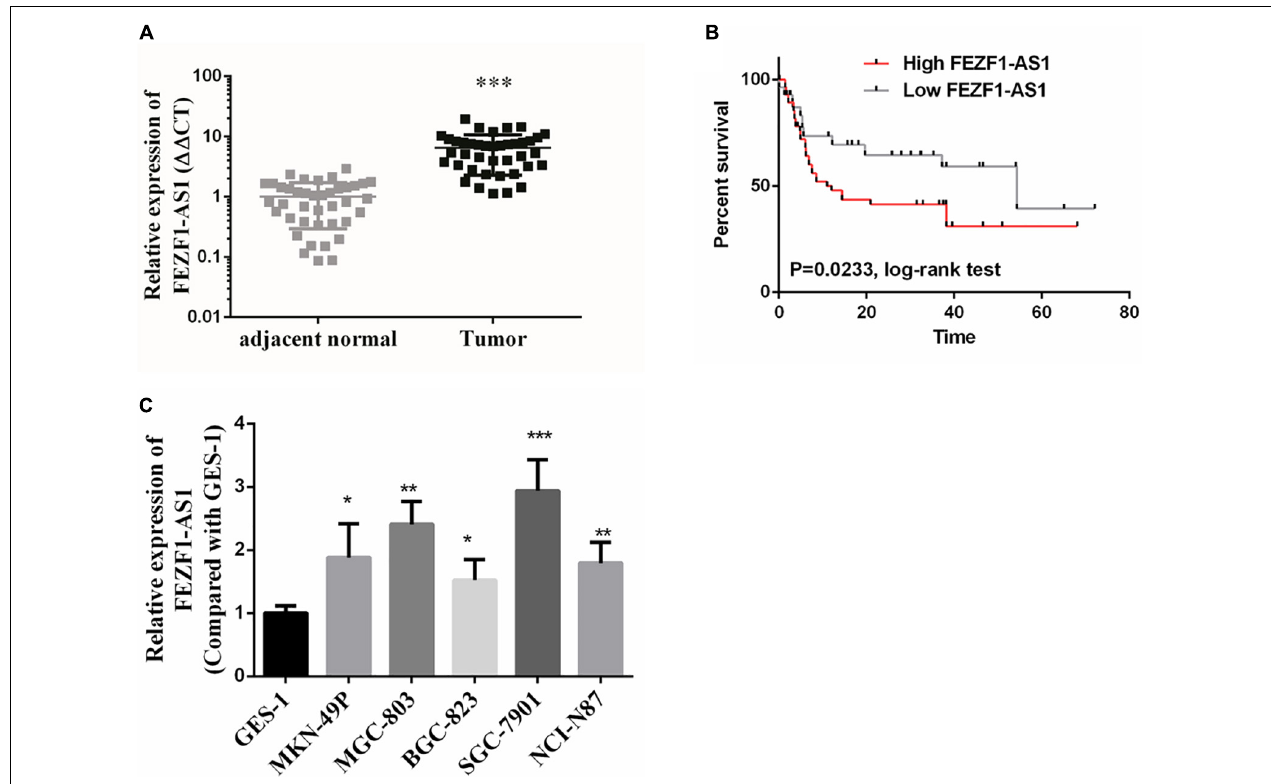
FIGURE 1 | FEZF1-AS1 was upregulated in gastric cancer (GC) tissues and cell lines. (A) Relative expression of FEZF1-AS1 in 40 paired GC tissues and pair-matched adjacent normal tissues quantified by qRT-PCR. FEZF1-AS1 was upregulated ( > 2-fold) in 70% (28 of 40) of the GC tissues compared with that in the adjacent normal tissues. (B) Kaplan–Meier survival analysis of patient overall survival according to FEZF1-AS1 levels in GC tissues. Patients with high level of FEZF1-AS1 expression demonstrated reduced overall survival compared with patients with low expression. (C) FEZF1-AS1 expression in several types of gastric cancer cell lines and a normal human gastric epithelial cell line (GES-1) by qRT-PCR. Each experiment was performed in triplicate. Data are mean ± SD. * P < 0.05, ** P < 0.01, *** P <